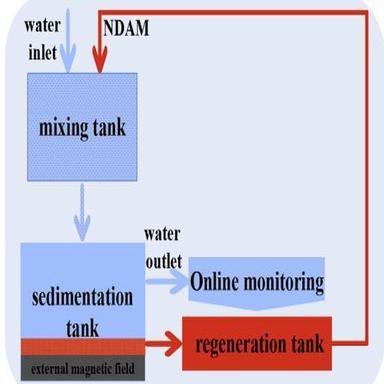
Potential application of the amphiphilic magnetic adsorption material in water purification.